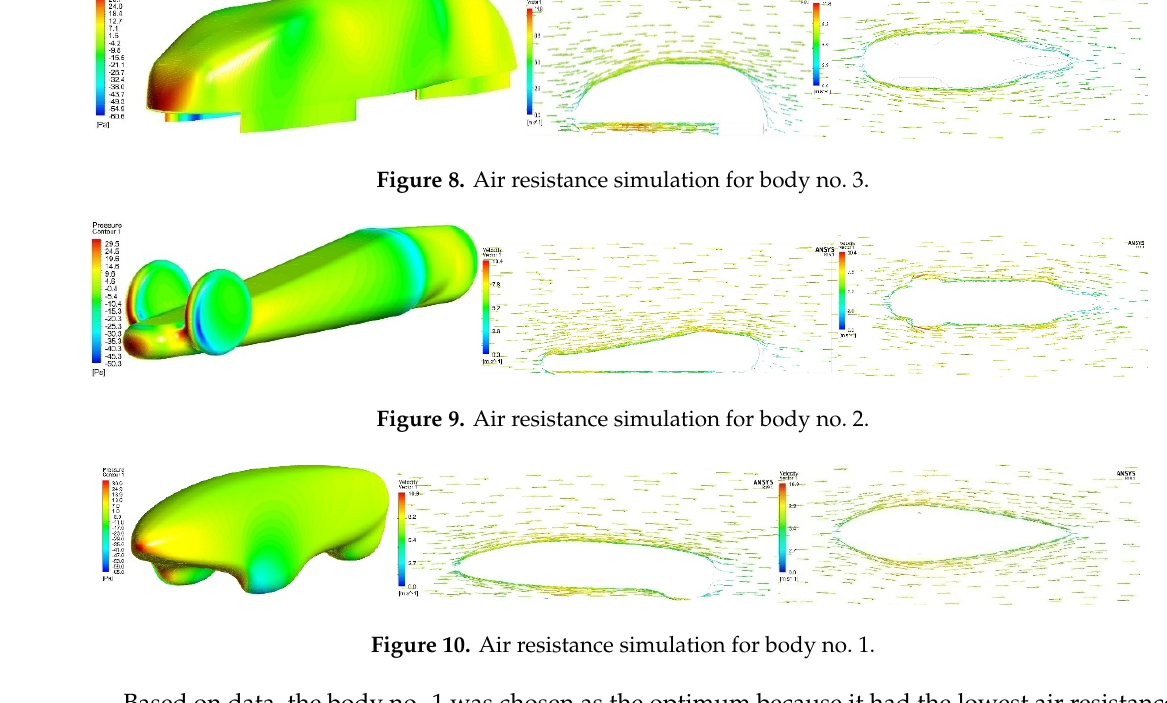
Table 2. Results from numerical calculations.